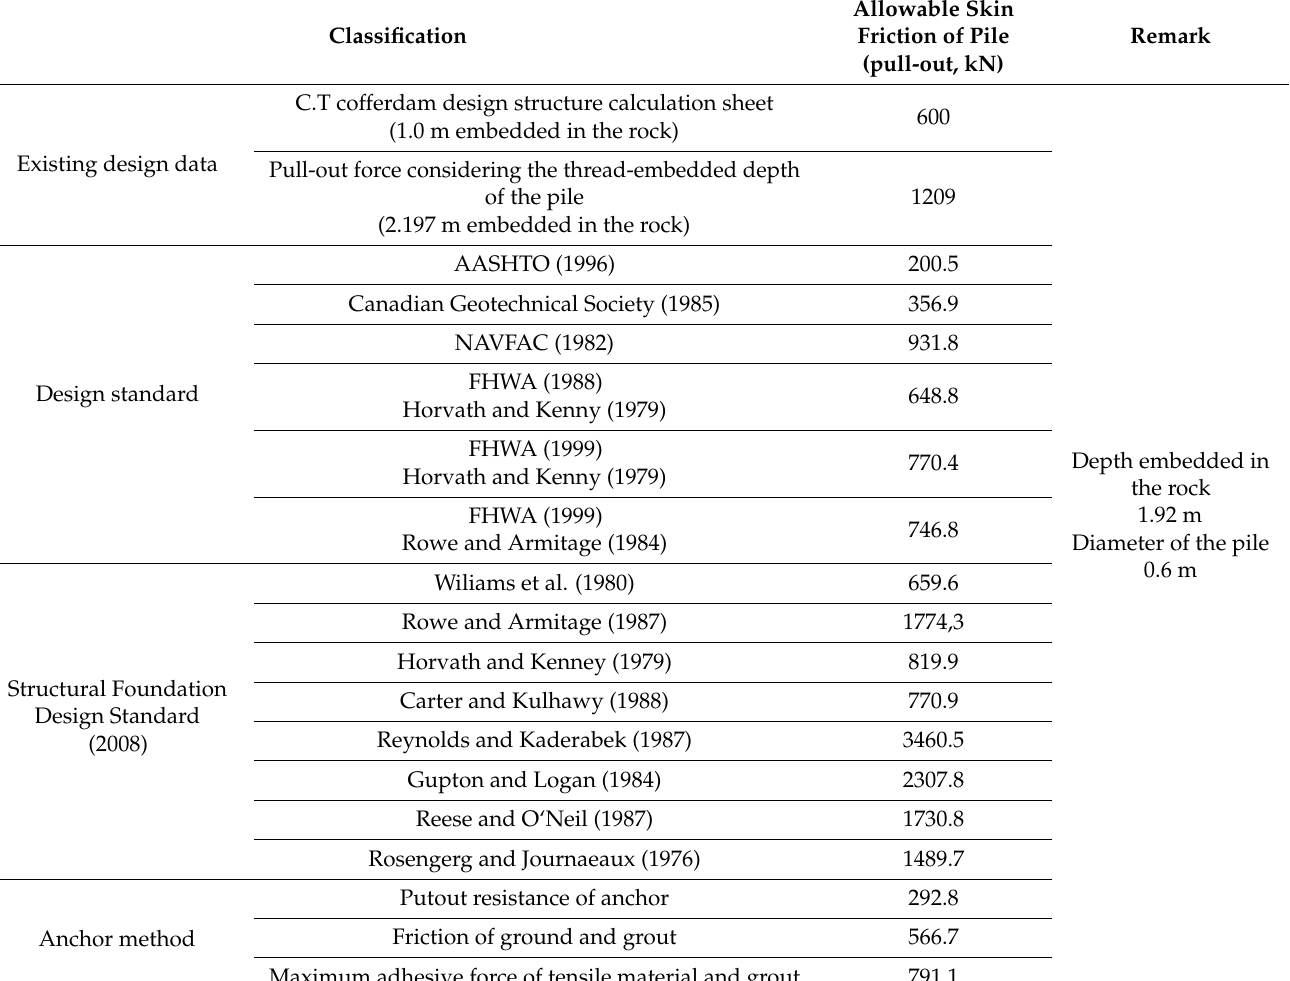
Table 3. Comparison of the pull-out force applied to the design and design standard values. Classification